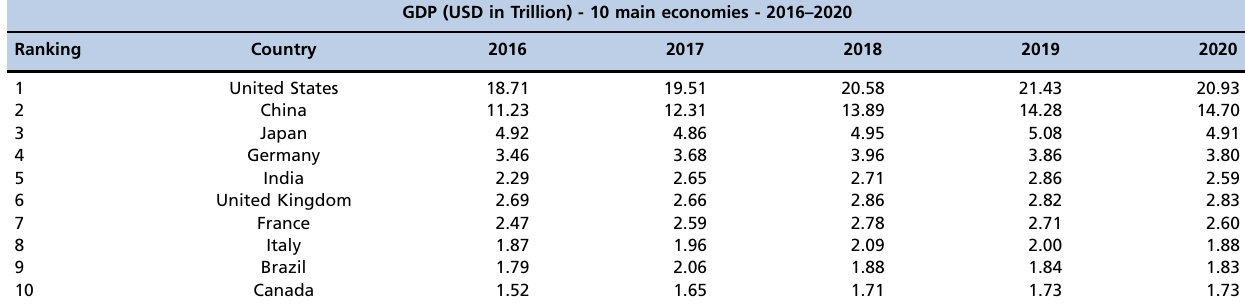
Table 2 - Ranking of Countries by GDP—2016–2020.